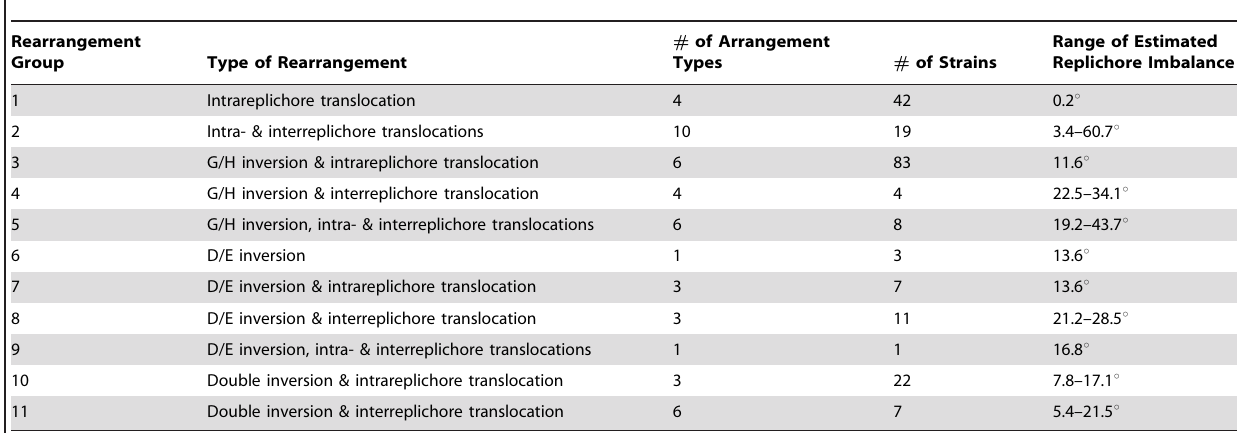
Table 2. Rearrangement groups of naturally-occurring arrangement types.